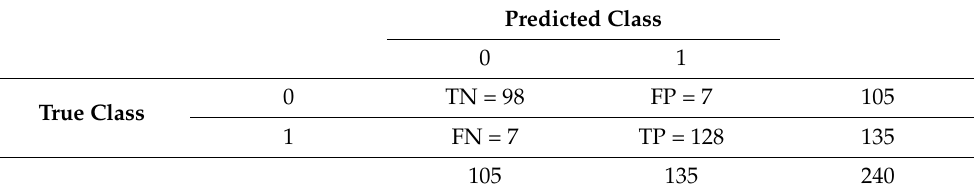
Table 5. Confusion matrix generated after binary